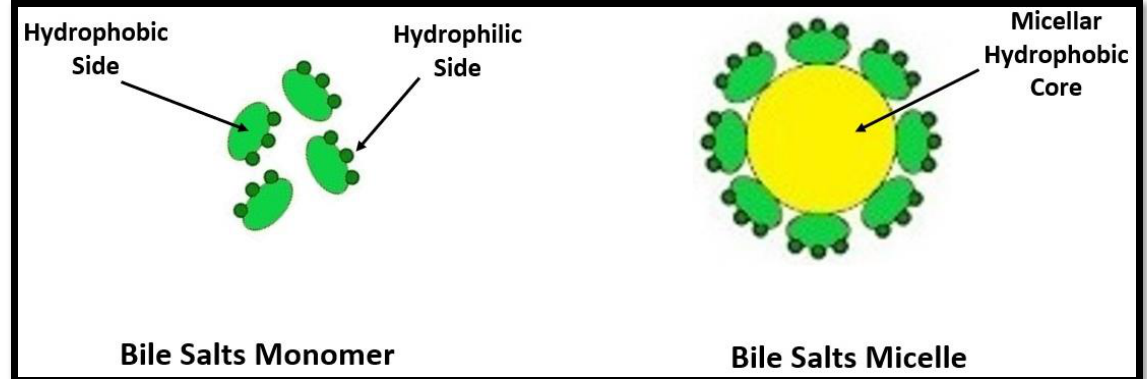
Table 1. Various specifications of chemicals taken in the present